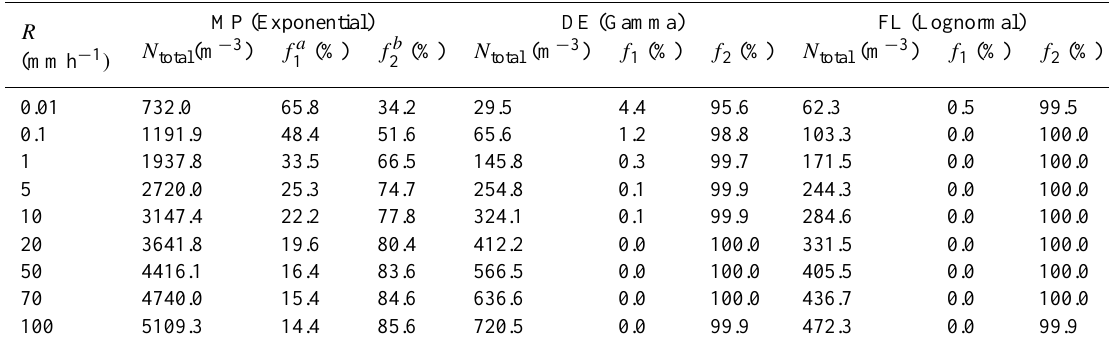
Table 2. Total droplet number concentration, N total , from three typical raindrop number size distributions for nine different rainfall intensities. MP denotes for Marshall and Palmer (1948), DE denotes de Wolf (2001), and FL denotes Feingold and Levin